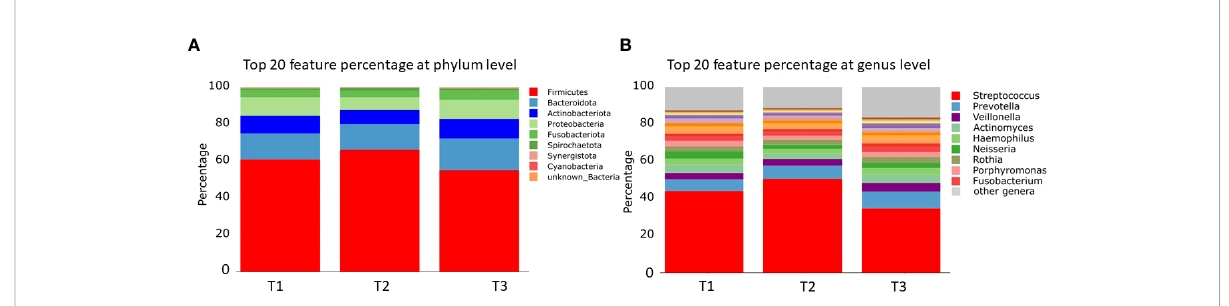
FIGURE 2 Bar charts of relative microbial abundance at the (A) phylum and (B) genus levels per sample group (the 20 most abundant taxa are shown). T1: before/at start of chemotherapy, T2: 12 weeks after the onset of chemotherapy, T3: 52 weeks after the onset of